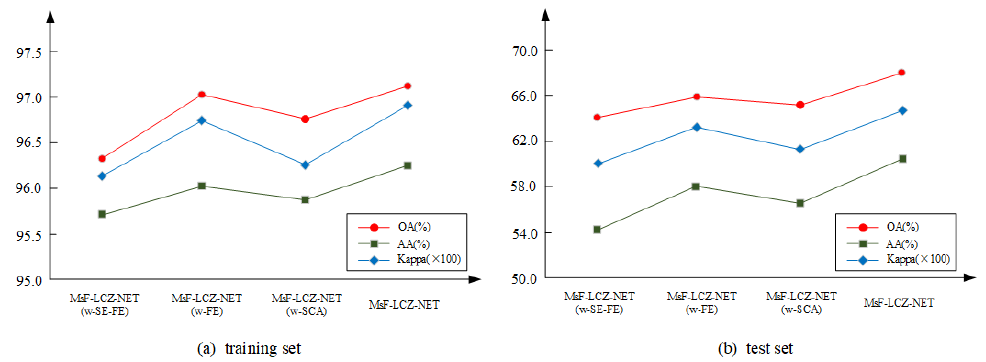
Figure 11. Mean values of OA, AA, and kappa based on three tests about different structures, evaluated on the training set ( a ) and test set ( b ) in the So2Sat LCZ42 dataset, respectively. Here, we use ‘w-’ to indicate without a specific